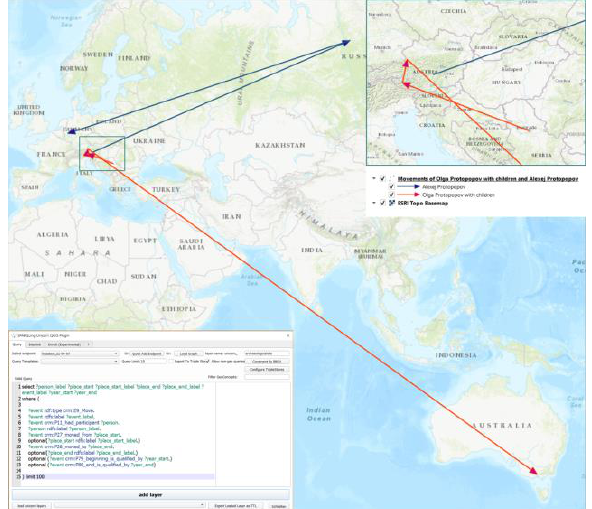
Figure 7. Visualization of parts of the movements from Olga Protopopov (in orange the example from the text) This makes it possible to visualize the lifeways of different peo- ple and fates, featured in the exhibition. For example, Olga Pro- topopov, whose life is the subject of poster 5, migrated with her two sons alongside her soldier husband from Belgrade, where her children were born, to Peggetz via several other stations. What cannot be shown in Figure 7, due to the density of the visualised the women featured in the other posters of the exhibition. With-